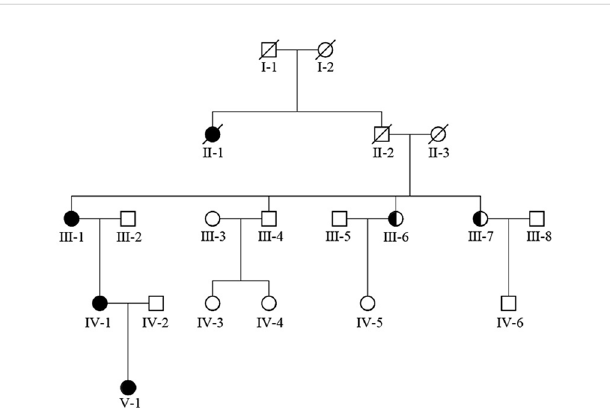
FIGURE 2 The loci of mutation in FRMD7. The mutation c.686G>T caused a substitution of Arg (R) to Leu (L) at position 229 (p.R229L) of the FRMD7 protein in the girl, her mother and grand-mother.